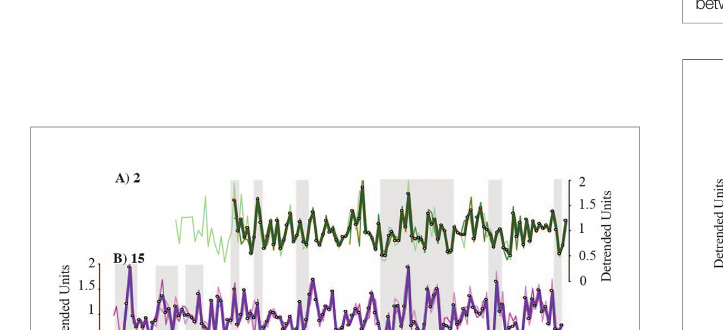
FIGURE 6 | Individual sample timeseries (thin coloured lines A – C ) compared to average of all other sample-mean series (black). Grey vertical bars highlight periods of strong coherence. Running correlations between samples presented as plotted R-values of running correlations (49-year windows) (D – F) . Flat black lines represent threshold of signi fi cance (p < 0.05). Average inter-series correlation between all specimens (Ravg) plotted in lowest panel (G) .